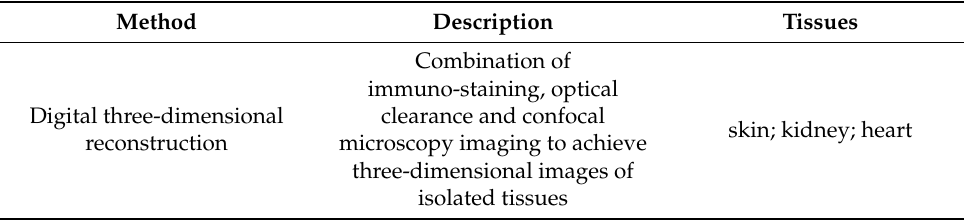
Table 1. Emerging technologies of lymphatic research